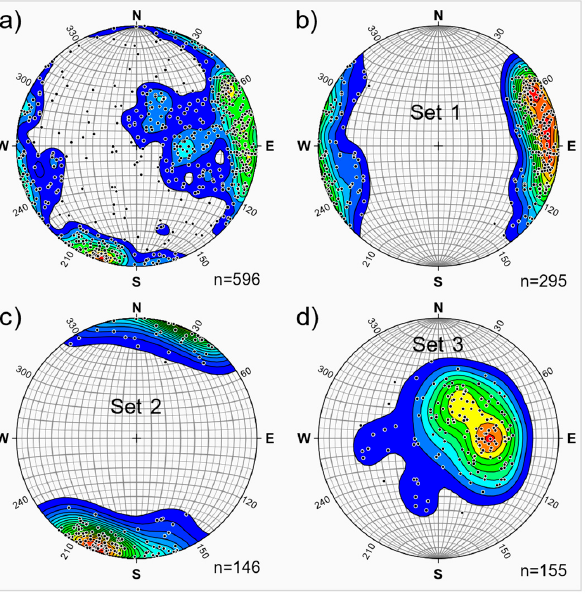
Figure 4. Discontinuity orientation data and clustering into three sets: ( a ) all measured data, ( b ) set 1, ( c ) set 2, and ( d ) set 3. Pole and contour plots were created using the software Stereonet [37,39].